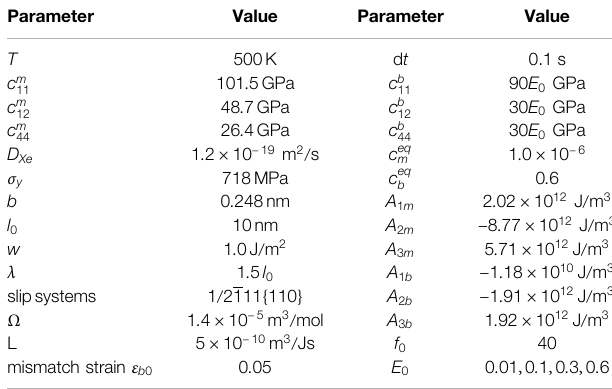
TABLE 1 | Model parameters of crystal plasticity and phase- fi eld model of gas bubble evolution for UMo crystals.